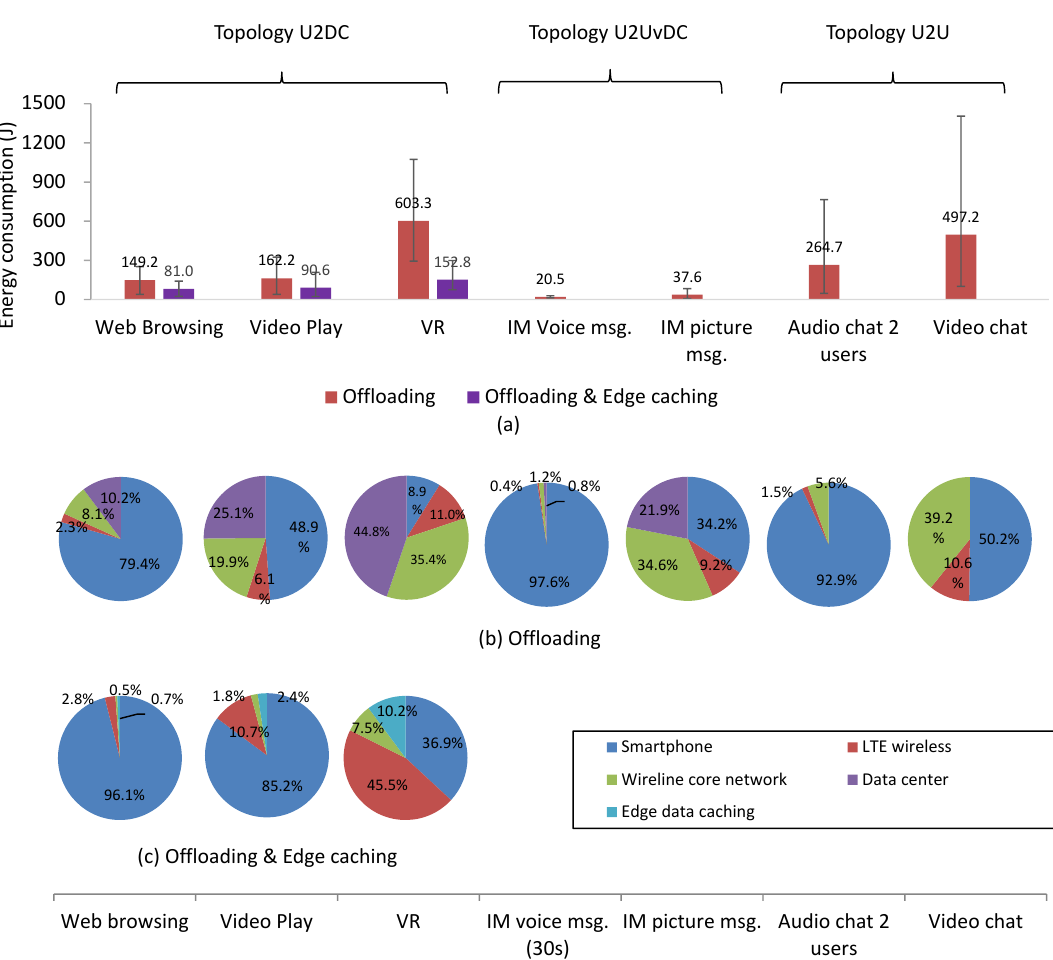
Figure 6. End-to-end energy consumption of typical mobile services under different test scenarios: (1) using offloading from macro cell to femto cell; and (2) using both small cell offloading and mobile edge caching. ( a ) End-to-end energy consumption under different user behaviors; ( b ) average energy breakdown when offloading; ( c ) average energy breakdown when offloading & edge caching. The error bars show the minimum and maximum usages of the services.